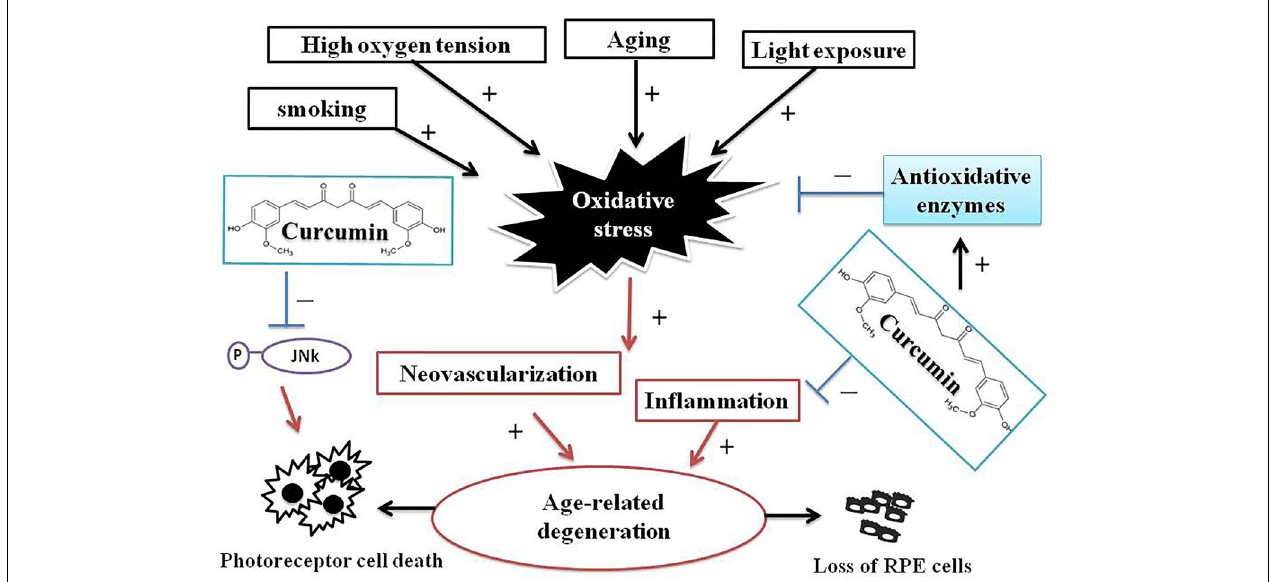
FIGURE 7 | A schematic illustrations of interrelations between curcumin and processes of AMD pathogenesis. AMD is a complex chronic neurodegenerative disease associated with many environmental, lifestyle, aging, and genetic factors. Oxidative stress and ROS production play a pivotal role in AMD pathogenesis. Curcumin has remarkable efficacy in ameliorating